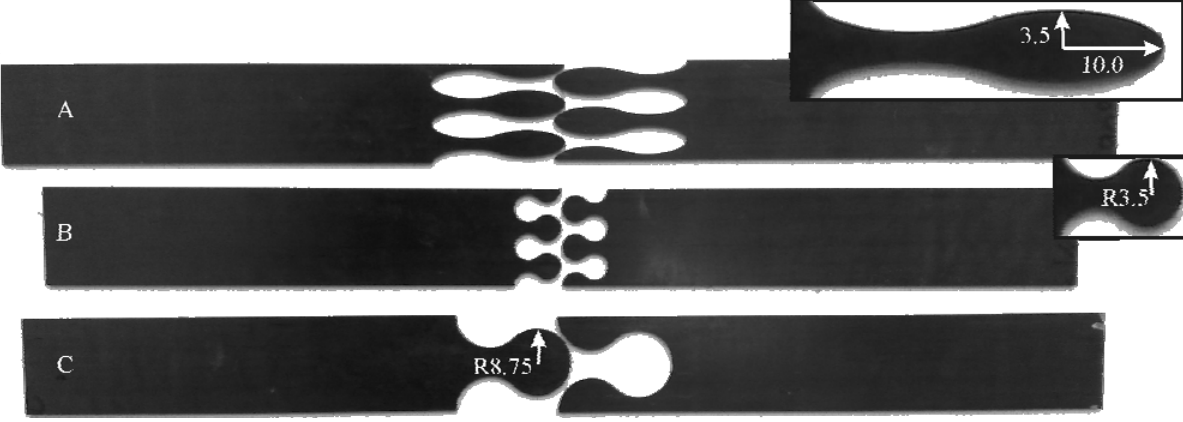
Figure 6. Tested interlock geometries.